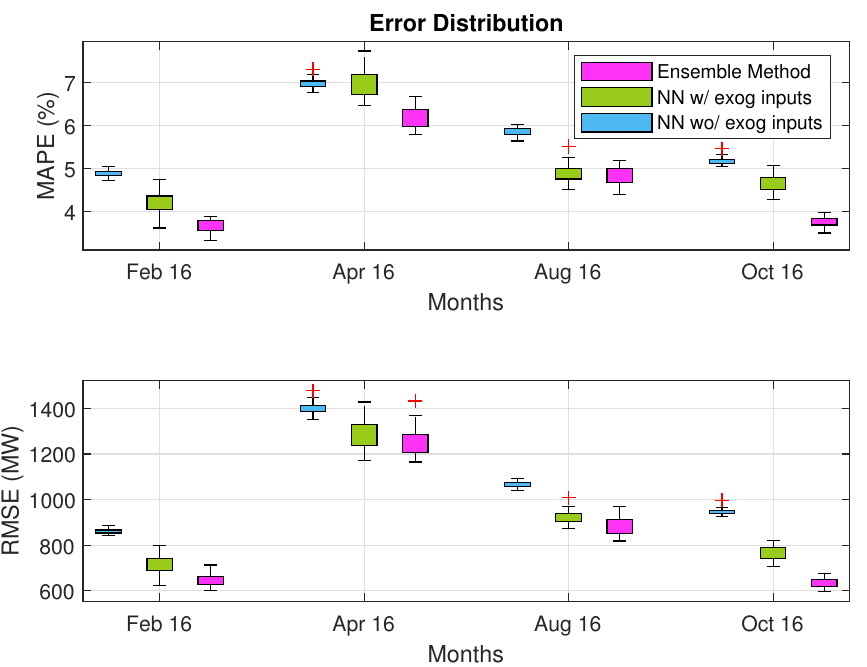
Figure 6. Box-plots of the MAPE (%) and RMSE (MW) error distributions (NN without exogenous inputs-blue, NN with exogenous inputs-green and the proposed ensemble methodology—magenta over the course of 50